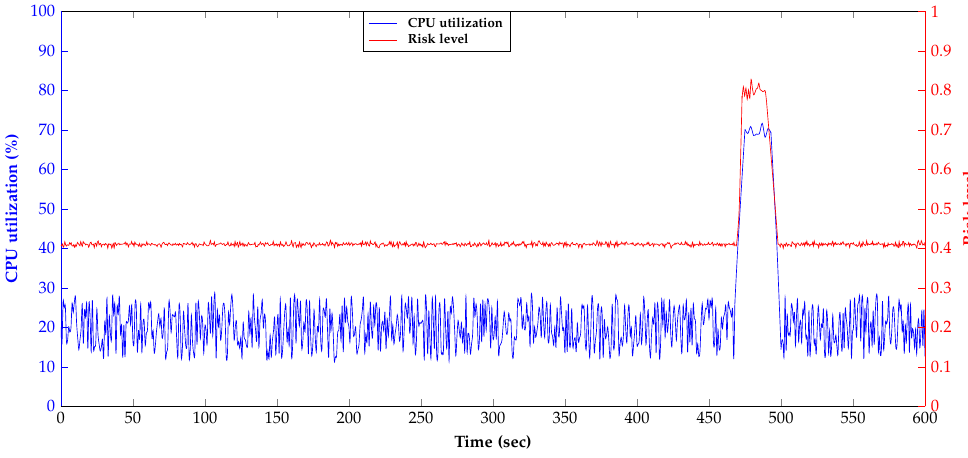
Figure 4. The relationship between the risk value and CPU utilization of virtual machine M 2 .